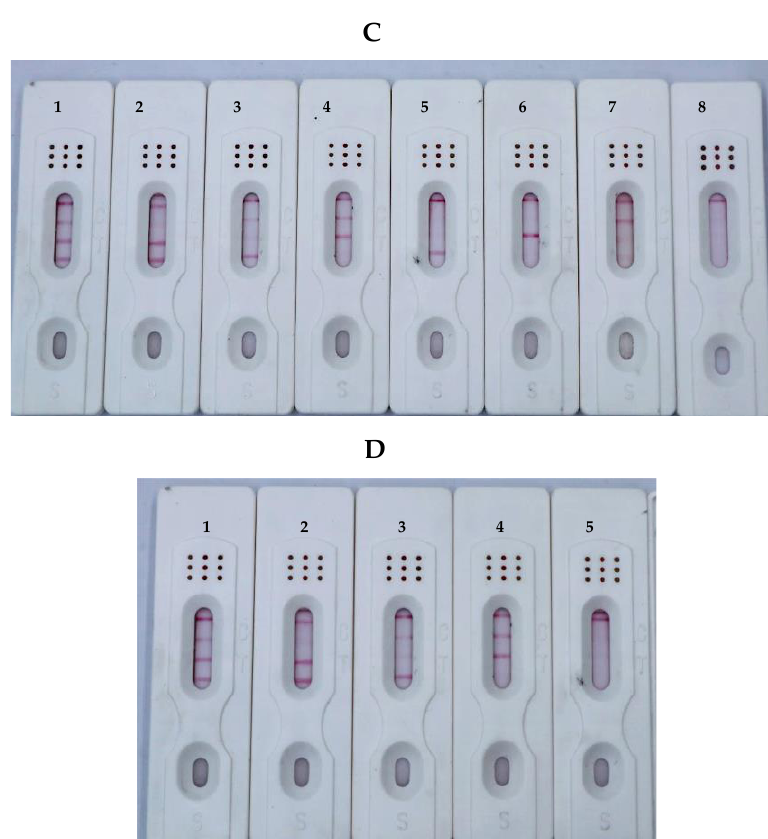
Figure 6. Sensitivity of the immunochromatographic strip (ICS) to ZEN ( A ), and T-2 ( B ). ( C ) Simultaneous detection of sensitivity for AFB 1 , ZEN, and T-2. Blank control (1); 0.5 ng/mL AFB 1 (2); 5.0 ng/mL ZEN (3); 5.0 ng/mL T-2 (4); 0.5 ng/mL AFB 1 + 5.0 ng/mL ZEN (5); 0.5 ng/mL AFB 1 + 5.0 ng/mL T-2 (6); 5.0 ng/mL ZEN + 5.0 ng/mL T-2 (7); 0.5 ng/mL AFB 1 + 5.0 ng/mL ZEN + 5.0 ng/mL T-2 (8). ( D ) Storage of the ICS for 120 days. Blank control (1); 0.5 ng/mL AFB 1 (2); 5.0 ng/mL ZEN (3); 5.0 ng/mL T-2 (4); 0.5 ng/mL AFB 1 + 5.0 ng/mL ZEN + 5.0 ng/mL T-2 (5).